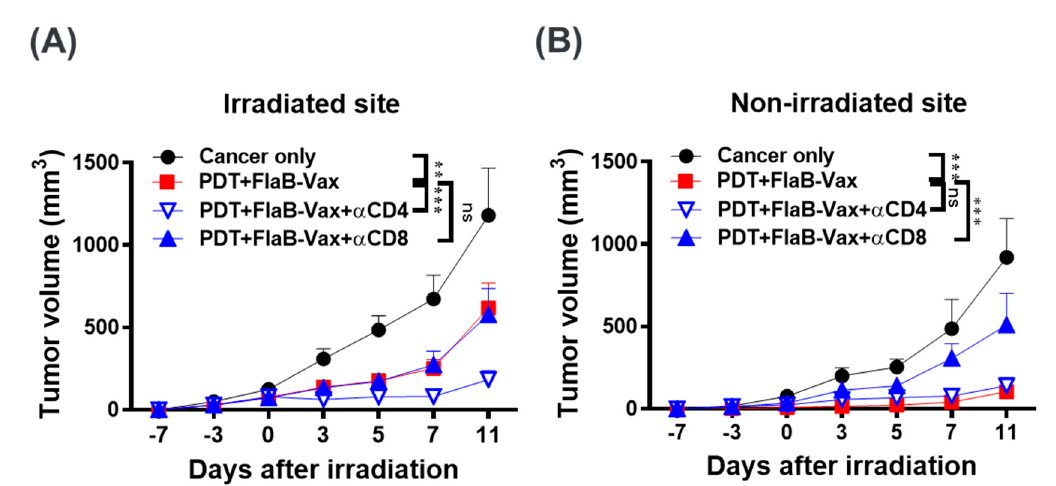
Figure 4. The tumor suppression effect of combination treatment was dependent on the treatment-induced systemic CD8 + T cell response. Depleting antibody was administered i.p. 2 days before FlaB-Vax or PDT treatment, resulting in > 98% depletion of CD4 + or CD8 + cells in the blood within 24 h after injection. Irradiated ( A ) and nonirradiated abscopal tumor growth ( B ) of B16-F10 tumor-bearing mice treated with PDT and FlaB-Vax after antibody-mediated depletion of CD4 + or CD8 + T cells ( n = 5 per group). Statistical significance was calculated by two-way ANOVA and Tukey’s multiple comparison test. **, p < 0.01; and ***, p < 0.001.